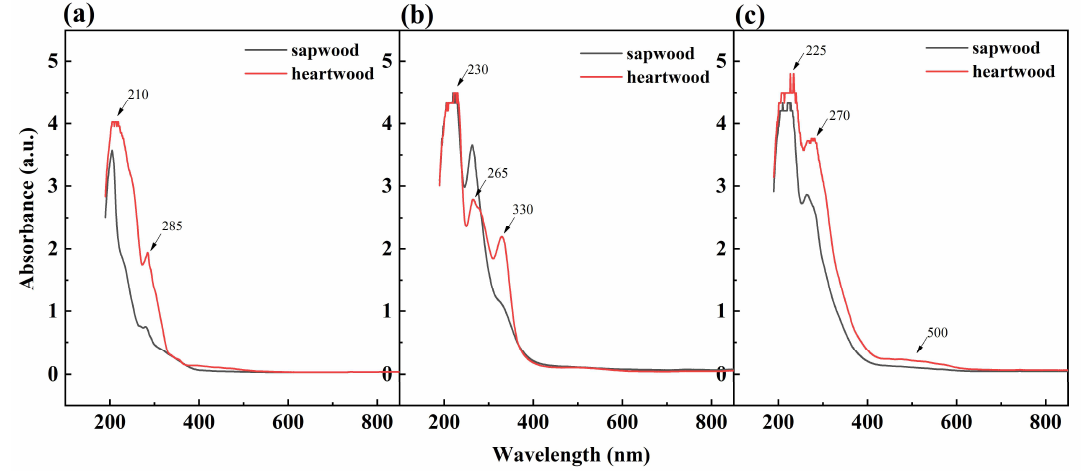
Figure 2. UV spectrum of D. oliveri heartwood and sapwood extract. ( a ) petroleum ether layer, ( b ) water layer, ( c ) ethyl acetate layer.